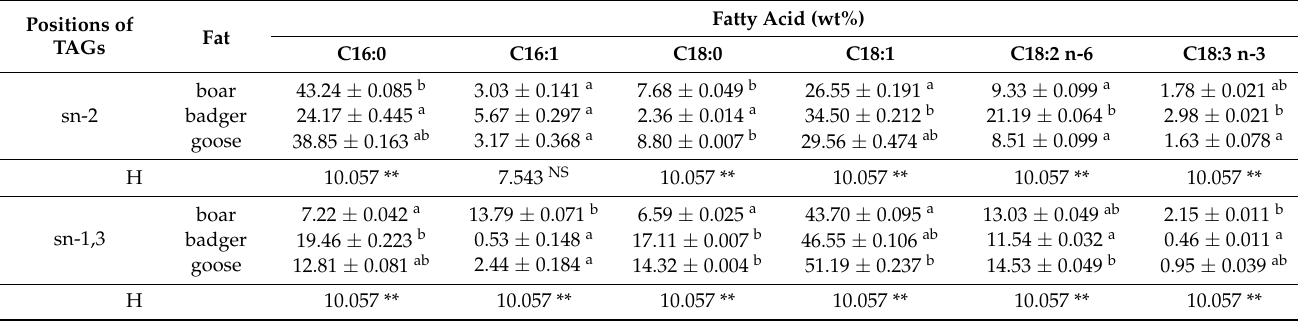
Table 2. Fatty acid composition in the internal and external positions of triacylglycerols (TAGs) of of boar, badger and wild goose fats.